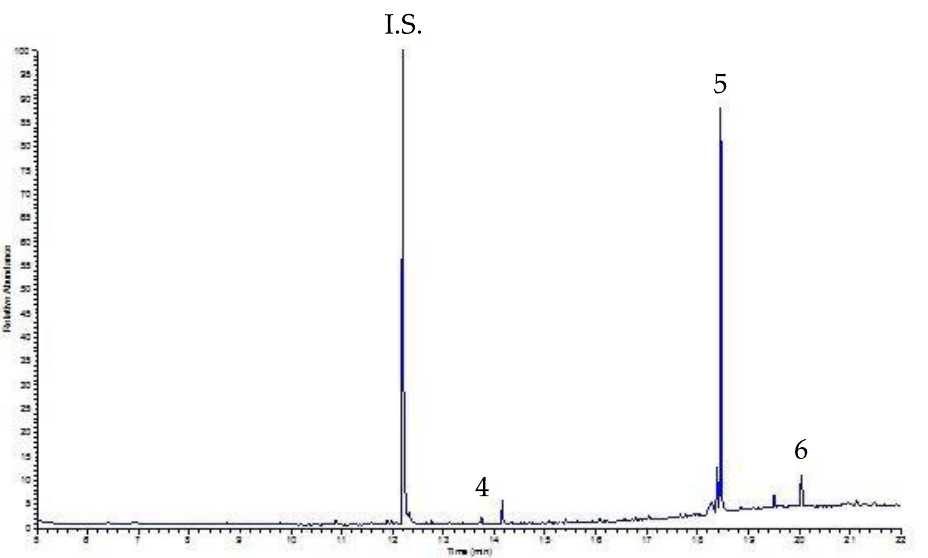
Figure 6. UVA-DLLME-GC-FID chromatogram of a decaffeinated coffee sample. Peaks: see Figure 4; for experimental conditions: see text.